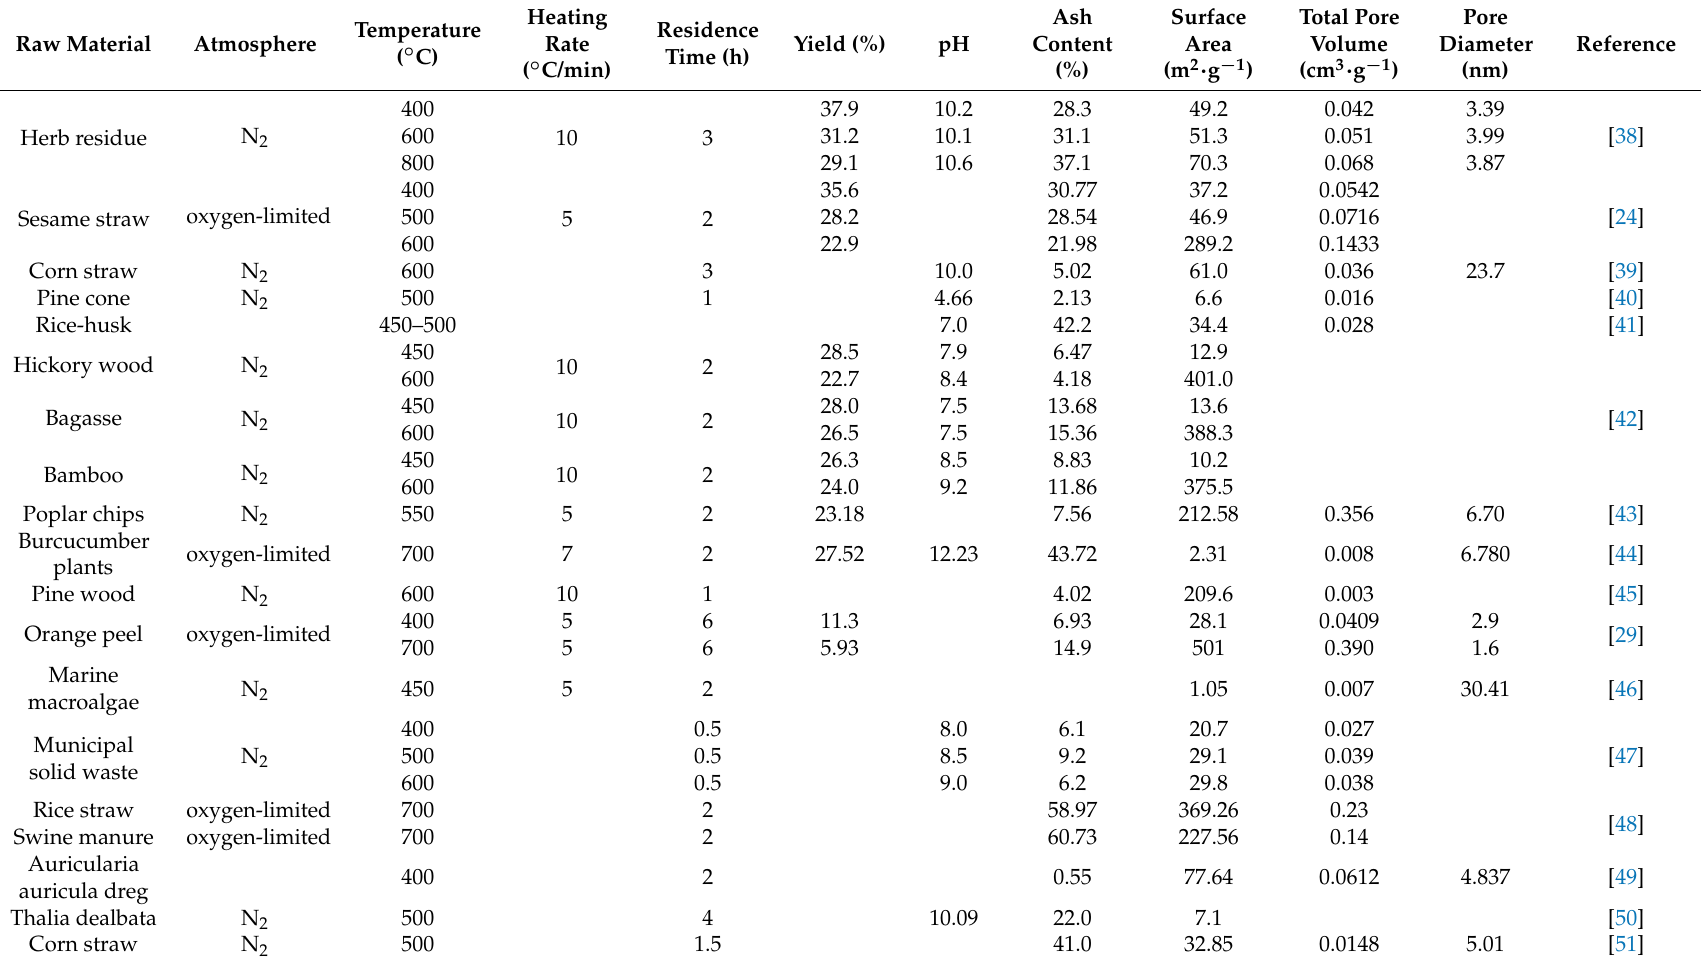
Table 1. Physicochemical properties of biochar prepared by different methods and process